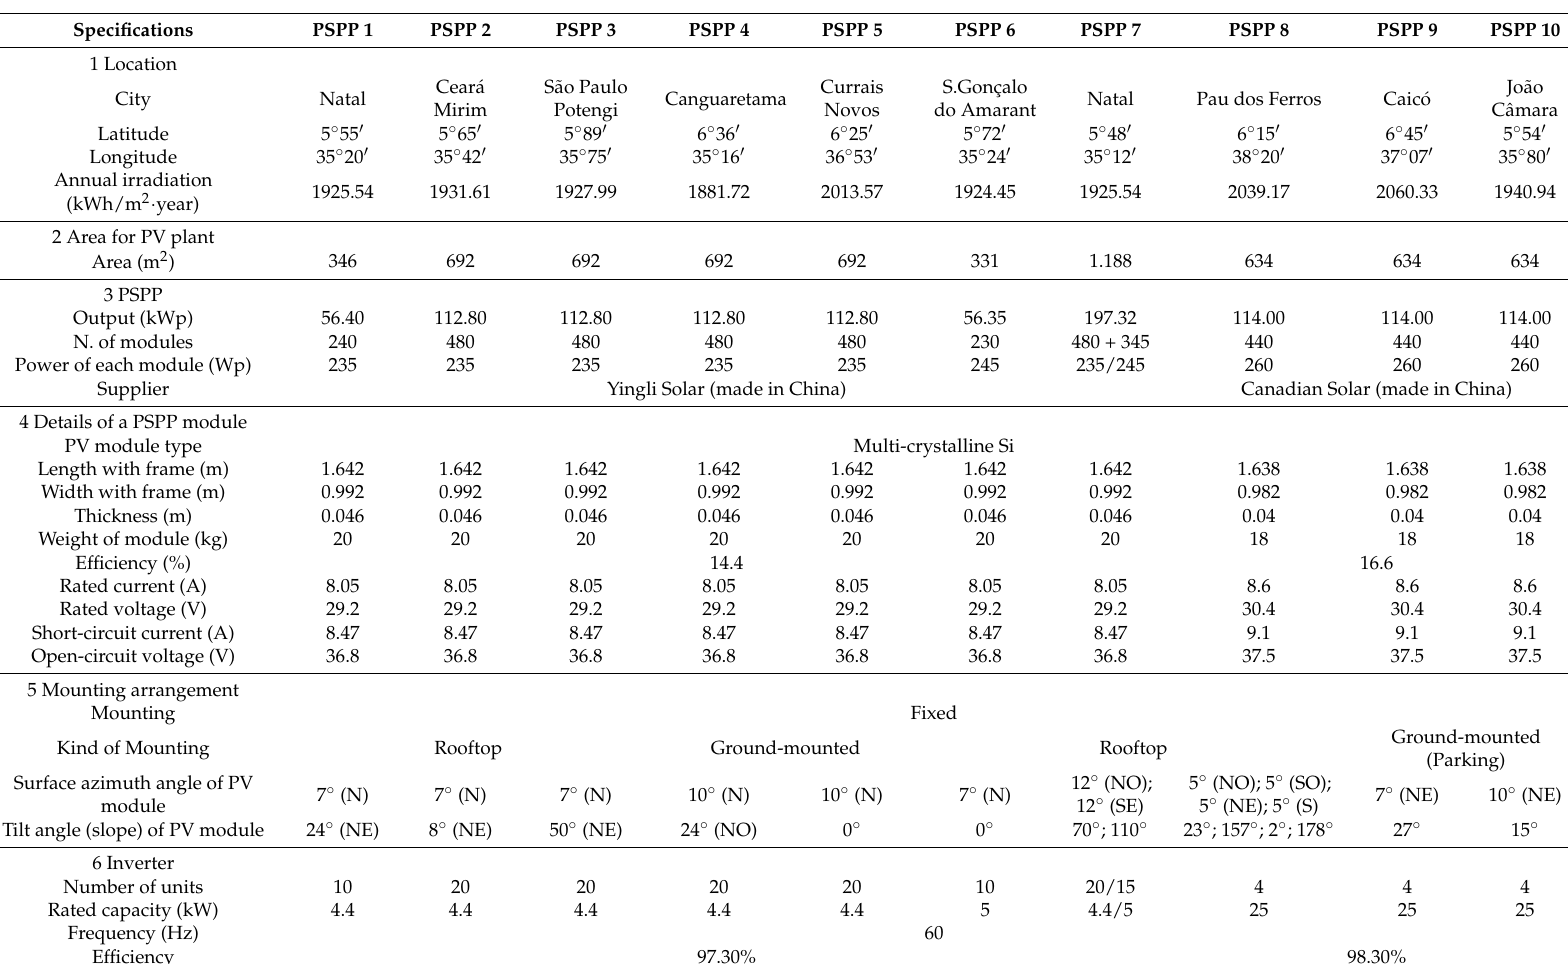
Table 6. Technical specifications of the evaluated photovoltaic solar power plants